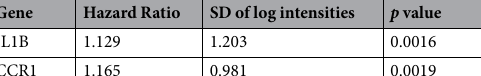
Gene Hazard Ratio